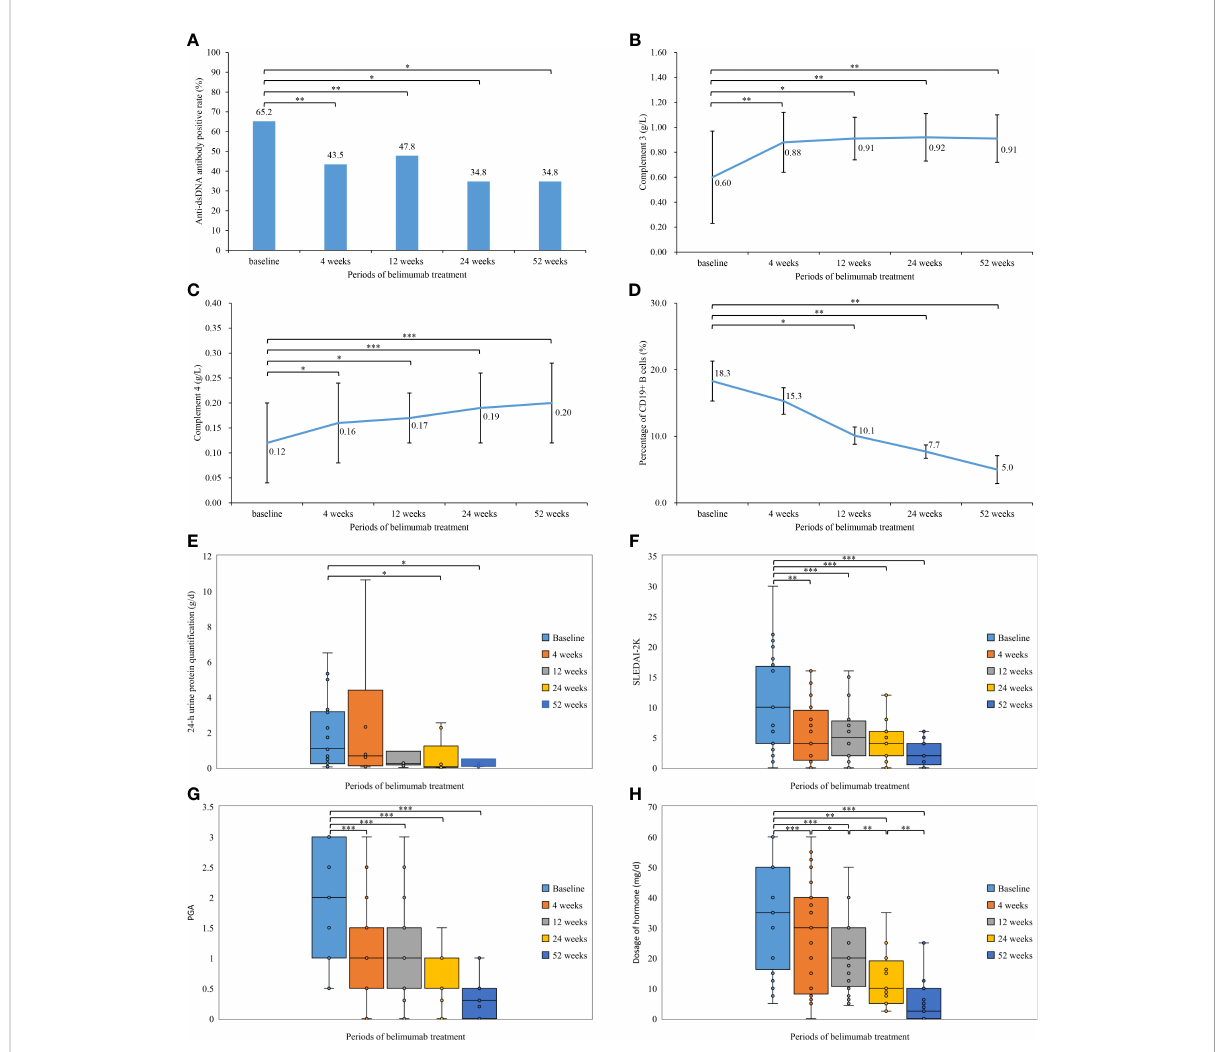
FIGURE 1 Comparison of the laboratory tests, disease activity, and hormone dosage during the different periods of belimumab treatment (up to 52 weeks) in 23 childhood-onset systemic lupus erythematosus patients. (A) Anti-dsDNA antibody positive rate (%). (B) Complement 3 (g/L). (C) Complement 4 (g/L). (D) Percentage of CD19 + B cells (%). (E) 24-h urine protein quanti fi cation (g/d). (F) Systemic Lupus Erythematosus Disease Activity Index 2000. (G) Physician ’ s Global Assessment. (H) Dosage of hormone (mg/d). * P < 0.05; ** P < 0.01; *** P <